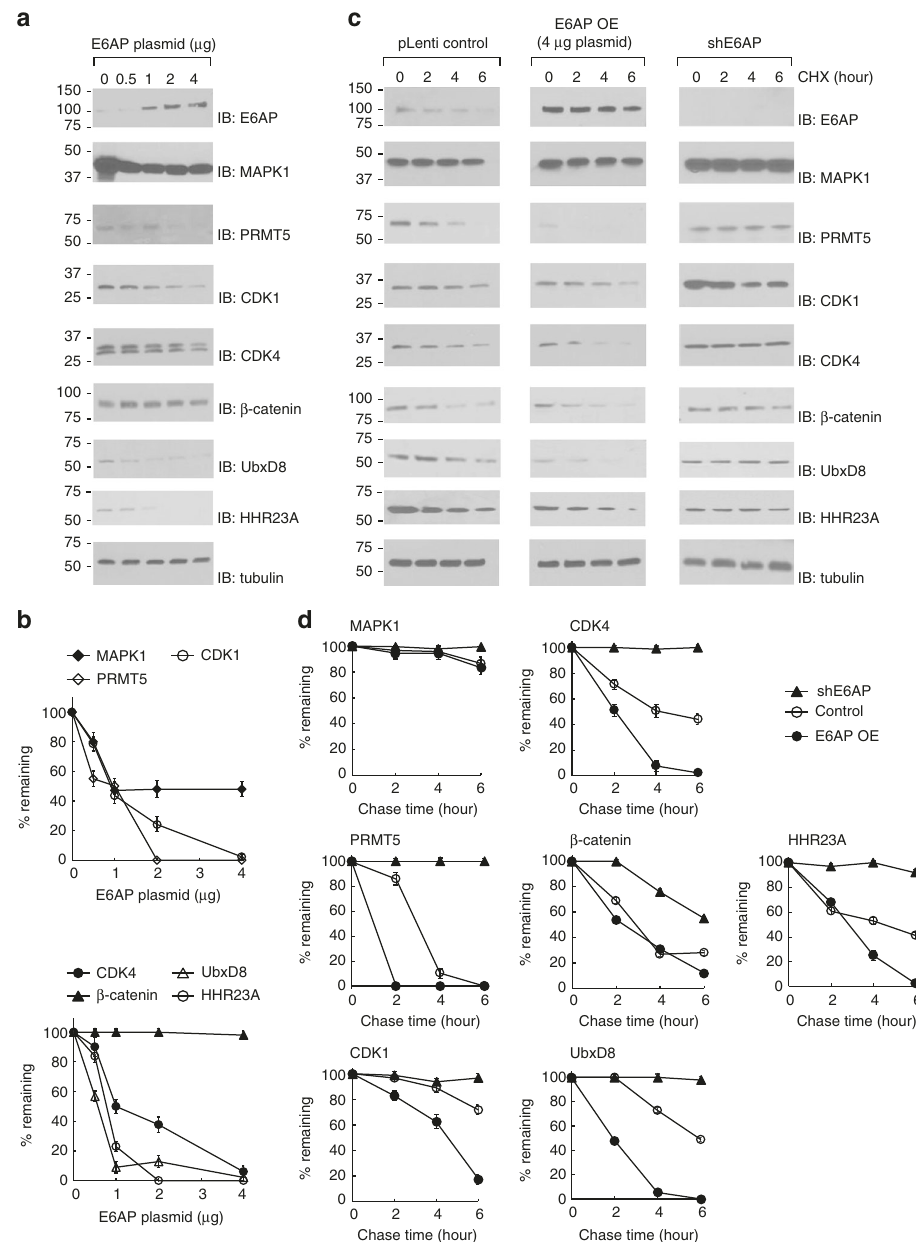
Fig. 7 Effect of E6AP expression on the stability of the substrate proteins. a E6AP decreases the steady-state levels of the substrate proteins in the HEK293 cells. Cells were transfected with increasing amount of E6AP plasmid. Levels of the E6AP substrates were assayed with immunoblots of the cell lysate probed with substrate-speci fi c antibodies. Approximately 5 × 10 6 cells were used for each transfection of the E6AP plasmid. b Quantitative analysis of substrate levels in correlation with E6AP expression. Intensity of the bands in a were plotted against the amount of pLenti E6AP plasmid used for transfection assuming 100% of substrate protein when an empty plasmid was used for mock transfection. Results were the average of three repeats. c E6AP-dependent degradation of substrate proteins assayed by cycloheximide (CHX) chase. HEK293 cells (5 × 10 6 cells) were transfected with 4 μ g of pLenti E6AP plasmid with the same amount of empty pLenti plasmid used in the controls. The cells were treated with 100 mg/ml CHX 48 h after transfection. Cell extracts were collected at 0, 2, 4, and 6 h after incubation with CHX, followed by immunoblotting with substrate-speci fi c antibodies. d Quantitative analysis of the levels of the substrate proteins in the cell in the CHX chase experiment. Data are representative of three independent experiments. Besides the new substrates identi fi ed by OUT, HHR23A, a known E6AP substrate, was assayed for its degradation regulated by E6AP. The vertical bars in b and d represent s.e.m. from three independent